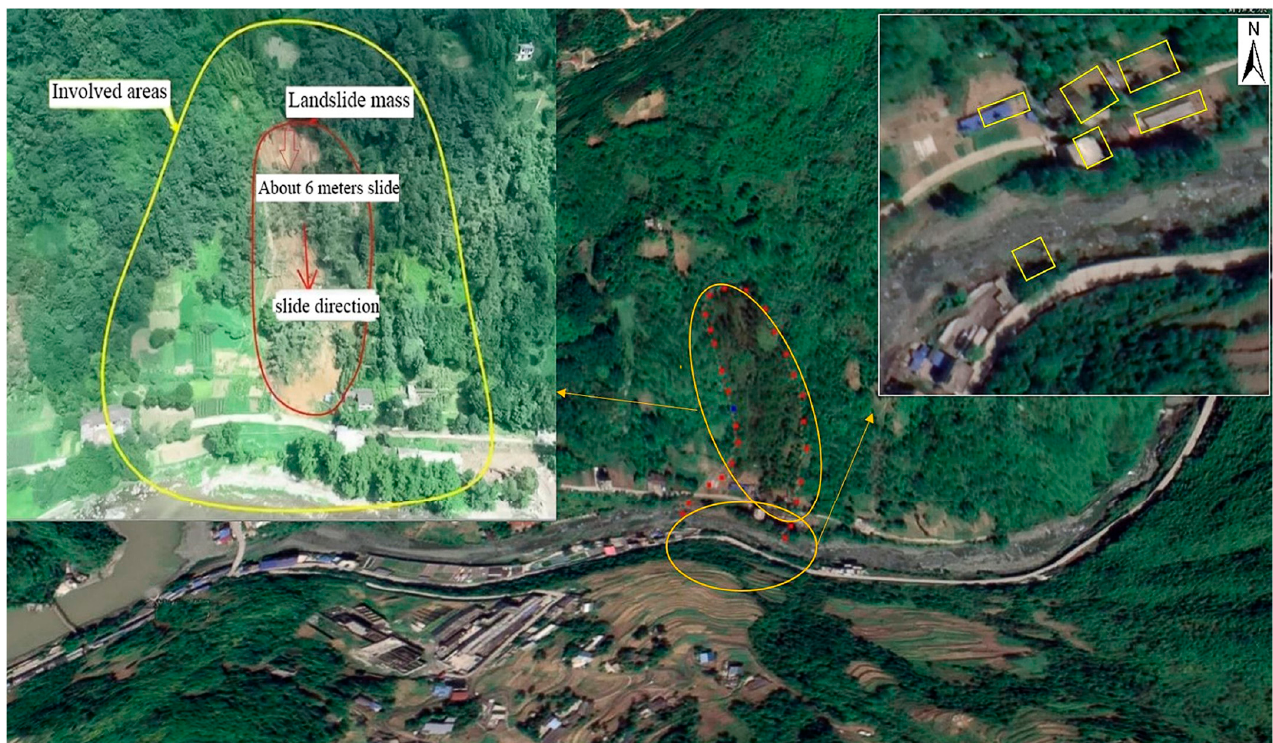
Figure 2. Remote sensing image of the landslide and surrounding damage (a UAV image is shown at the top-left).